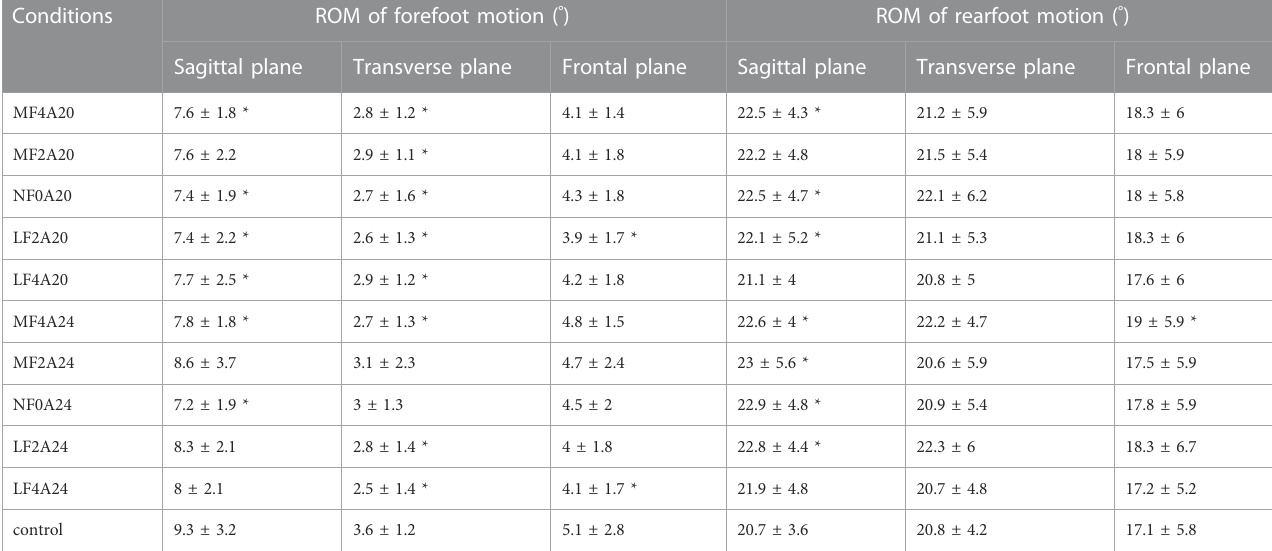
TABLE 2 Comparison of joint ROM (mean ± SD) between FOs and the control during the stance phase of jogging. Conditions ROM of forefoot motion ( ° ) ROM of rearfoot motion ( °